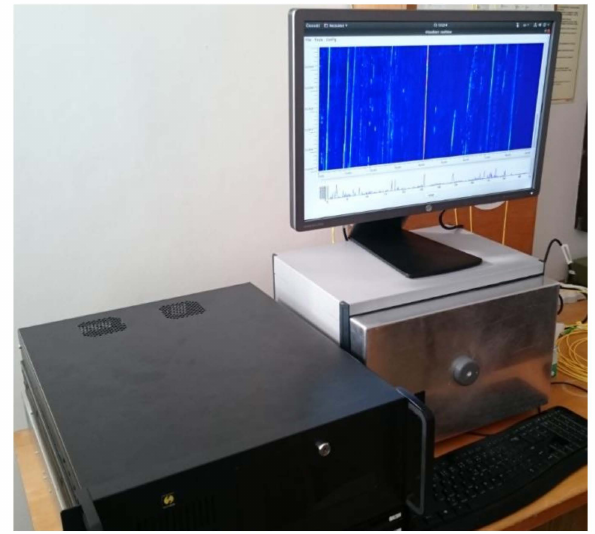
Figure 11. The single-fiber sensor unit testing in a real deployment. The beat signal after the o/e conversion is shown in Figure 12.